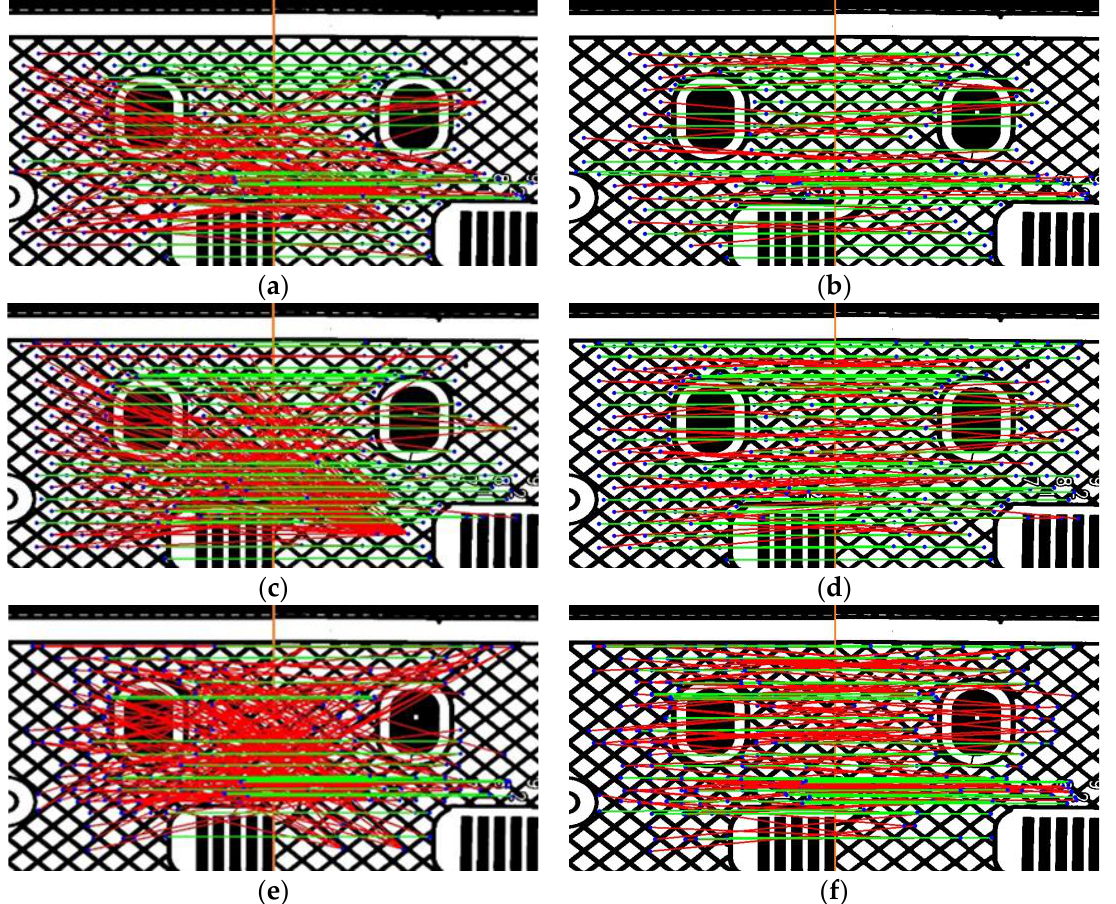
Figure 12. Qualitative evaluation of the proposed descriptor. Green and red lines refer respectively to correct and wrong matches. ( a ) SIFT matching result; matching precision rate is 33% (proportion of correct matching to total matching). ( b ) SIFT + BNCD matching result; matching precision rate is 48%. ( c ) SURF matching result; matching precision rate is 29.5%. ( d ) SURF + BNCD matching result; matching precision rate is 56%. ( e ) ORB matching result; matching precision rate is 13.5%. ( f ) ORB + BNCD matching result; matching precision rate is 31%.